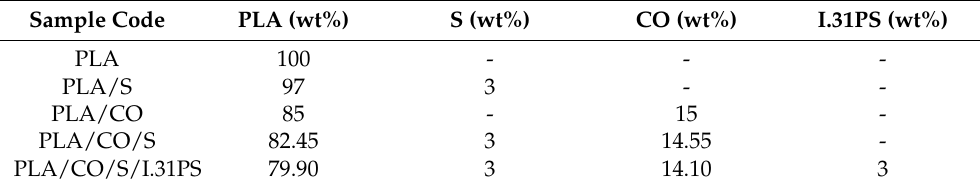
Table 2. Notations and compositions of the developed PLA-based